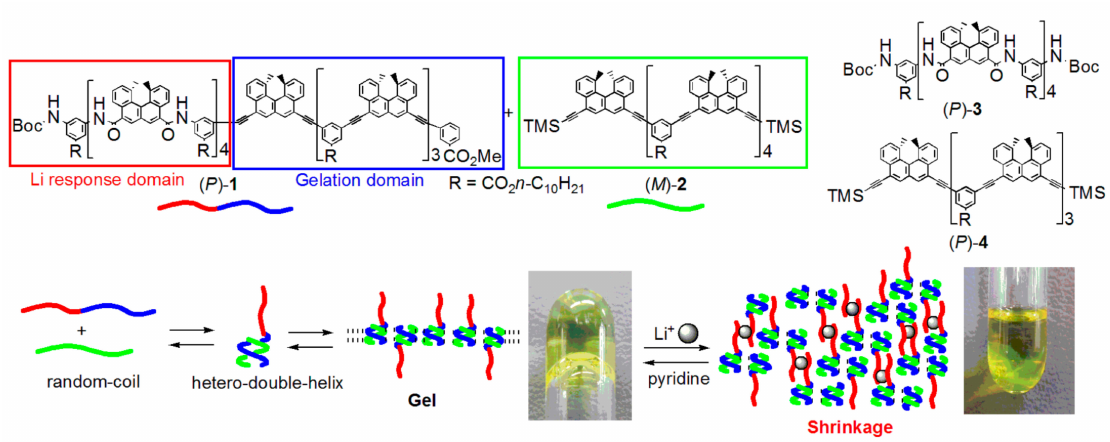
Figure 24. Synthesis of function by bi-domain ( P , P )-compound and ( M )-tetramer upon addition and removal of lithium